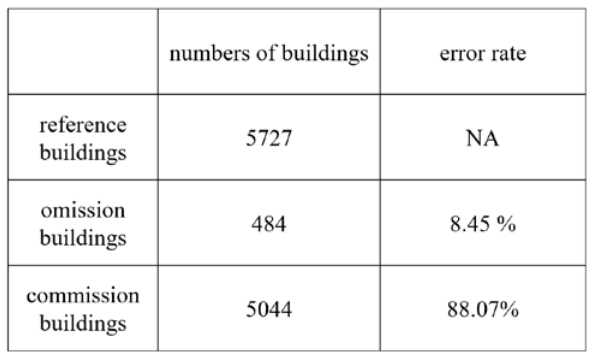
Table 2. Statistics of omission and commission buildings with the calculation of OER and CER.